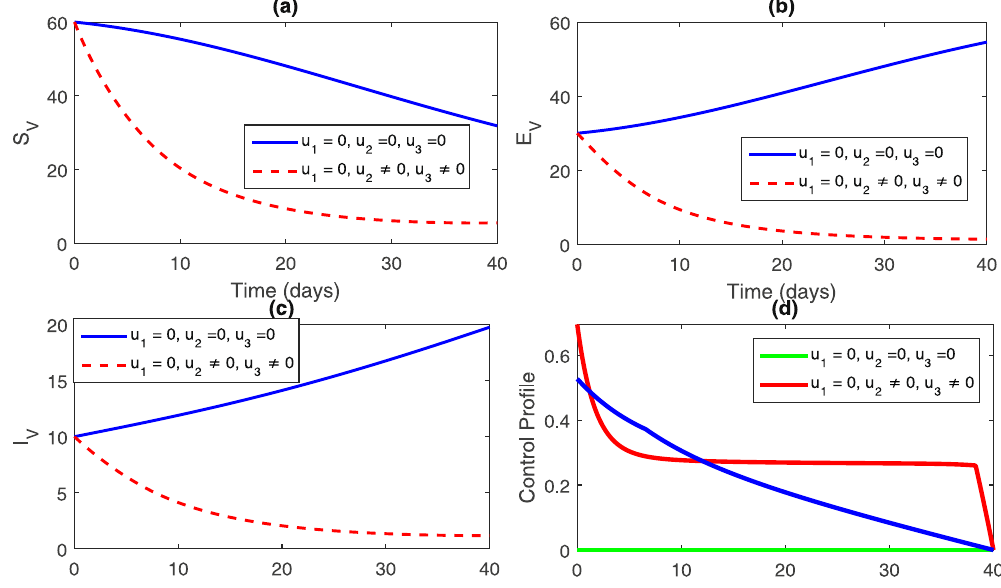
Figure 3. Comparison of both the systems: without and with control.